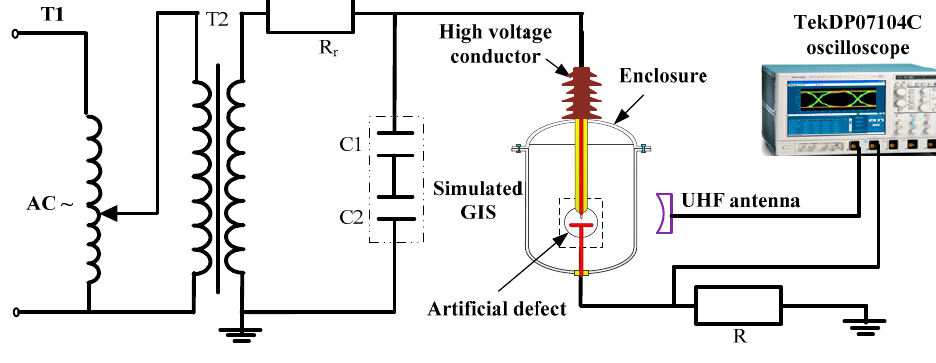
Figure 1. Schematic of the PD experimental setup.